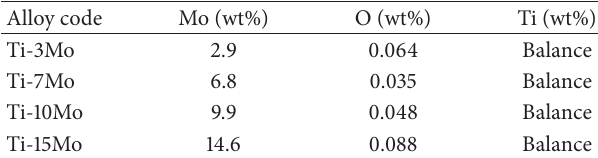
Table 1: Chemical compositions of the studied Ti-Mo alloys. Alloy code Mo (wt%) O (wt%) Ti (wt%) Ti-3Mo